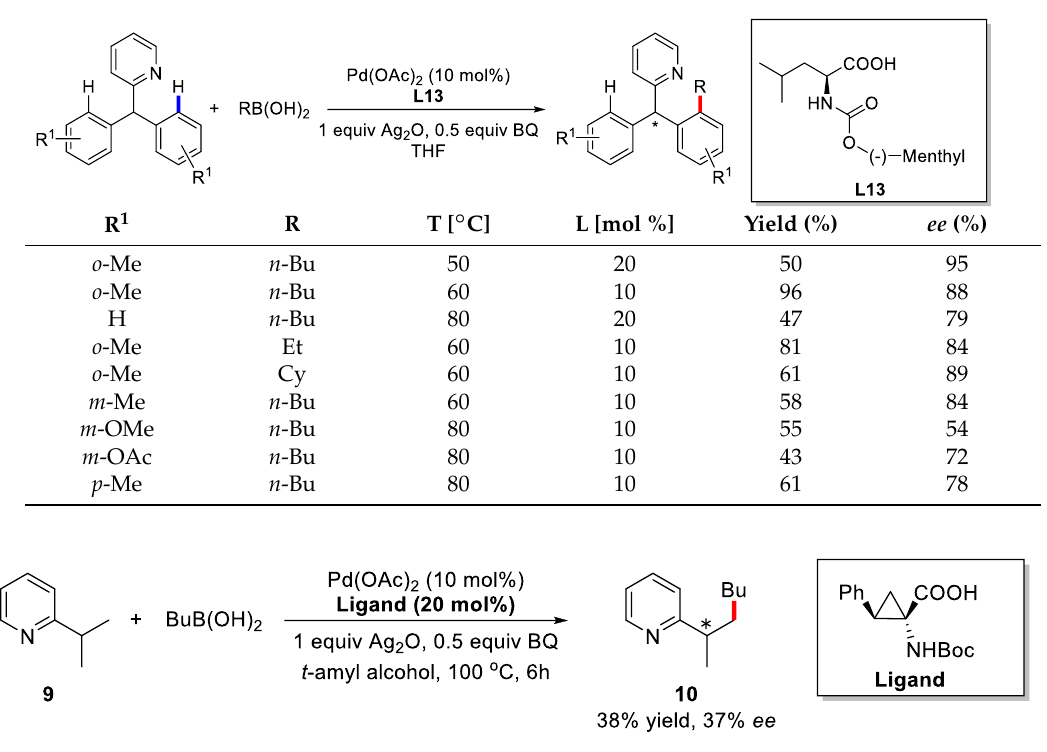
Table 1. Investigation on substrate scope [62].